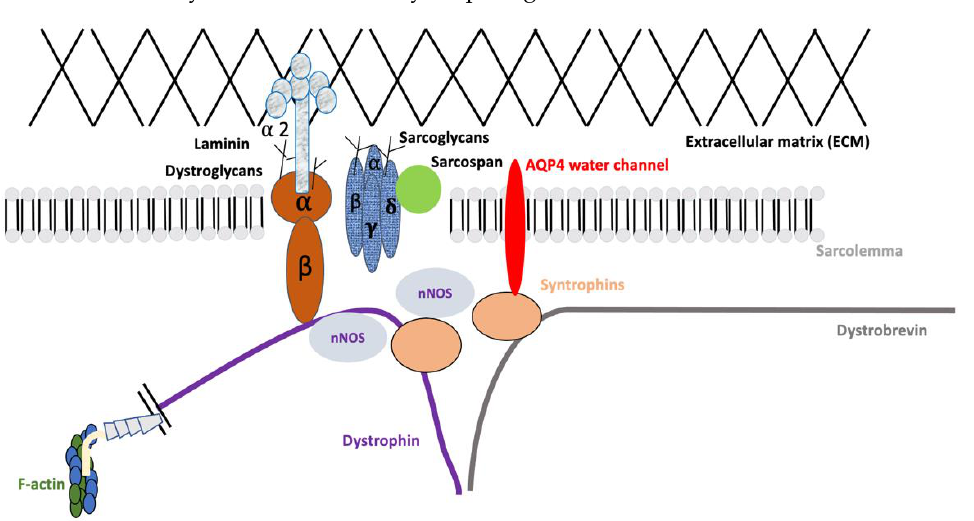
Figure 1. Representation of the DAPC complex in the skeletal muscle. The DAPC complex is a multicomponent system divided into subcomplexes: dystroglycans and sarcoglycans. The cytoplasmic components such as syntrophins and dystrobrevin serve as scaffolds for signalling proteins. AQP4 is localized in the sarcolemma. There are also other signalling molecules (ex. neuronal nitric oxide synthase, nNOS), kinases, ions, etc. Dystrophin, the largest protein in humans, stabilizes the sarcolemma by bridging the cytoskeletal actin to the extracellular matrix (ECM).